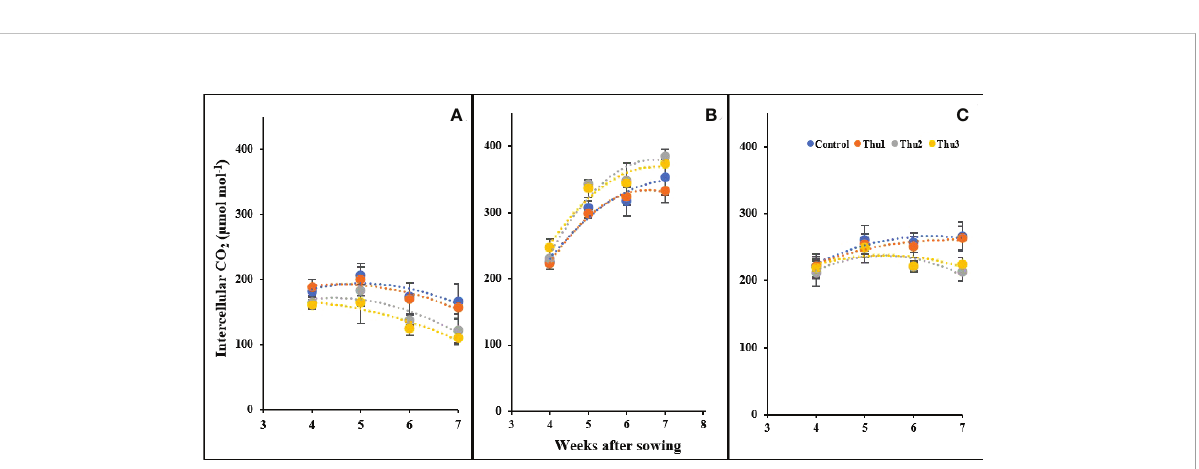
FIGURE 14 Changes in the intercellular CO 2 under application of Th17 at low (A) , optimum (B) and high (C) temperature at 4, 5, 6 and 7 weeks after sowing. Thu1: 10 -7 M Th17, Thu2: 10 -9 M Th17, Thu3: 10 -11 M Th17. Each point represents mean ± standard error